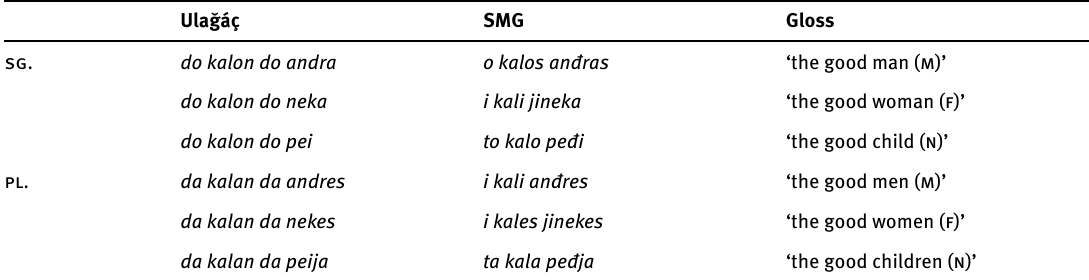
Table 8. Ulağáç and Standard Modern Greek (SMG) noun phrases